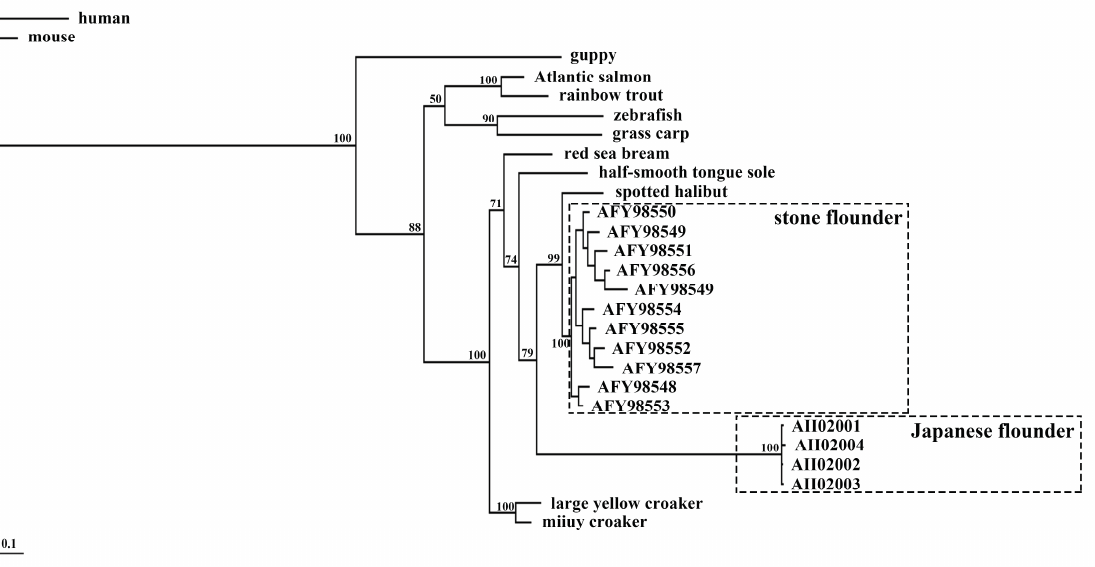
Figure 7. Phylogenetic tree of peptides encoded by MHC class II B in fourteen species. The human MHC class II B was set as an outgroup. The 11 alleles in stone flounder and the four alleles in Japanese flounder are indicated by their Genbank numbers. Sequences from other species are the same to those in Figure 6.